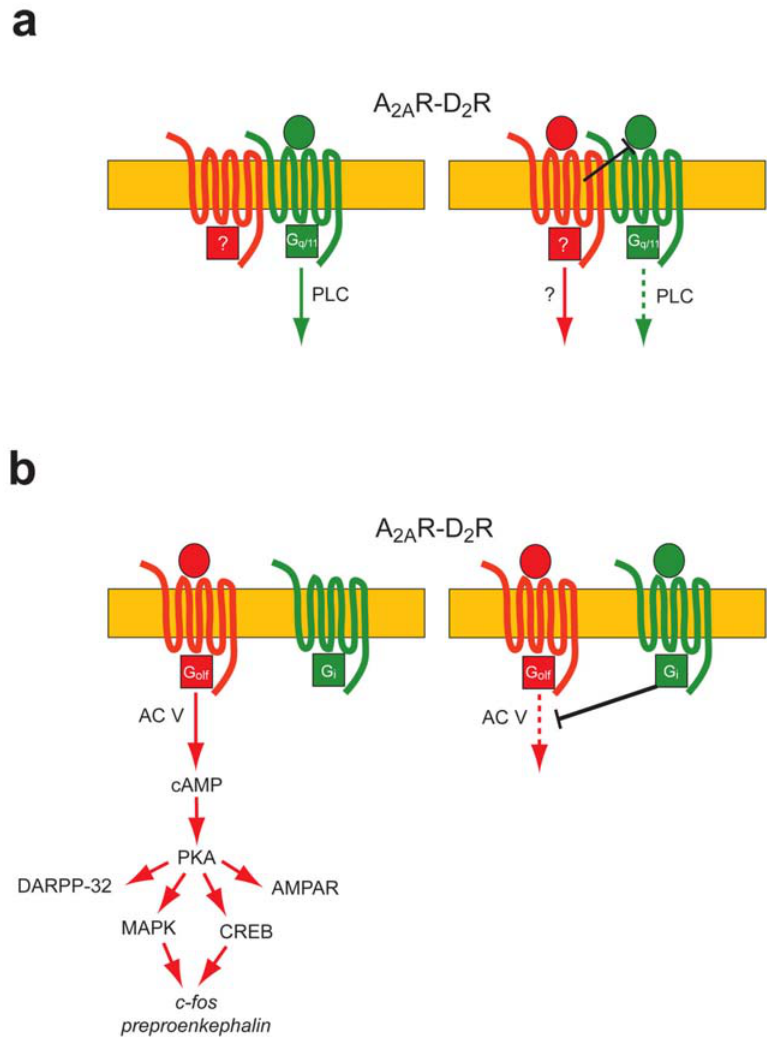
FIGURE 3. Adenosine A 2A -dopamine D 2 receptor interactions. (a) In the A 2A -D2 receptor heteromer, stimulation of the A 2A receptor decreases the binding of dopamine to the D 2 receptor; this intramembrane A 2A -D 2 interaction seems to involve a D 2 receptor-G q/11 -PLC signaling pathway. (b) In addition to the intramembrane interaction, in the striatum, a strong antagonistic interaction between A 2A and D 2 receptors has been found at the second messenger level, by which stimulation of G i -coupled D 2 receptors counteracts the activation of adenylyl-cyclase (subtype V; AC V) induced by stimulation of A 2A receptors and, therefore, the consequent activation of the cAMP-PKA-DARPP-32 signaling pathway and induction of the expression of different genes, such as c-fos and preproenkephalin ; this interaction might not depend on receptor